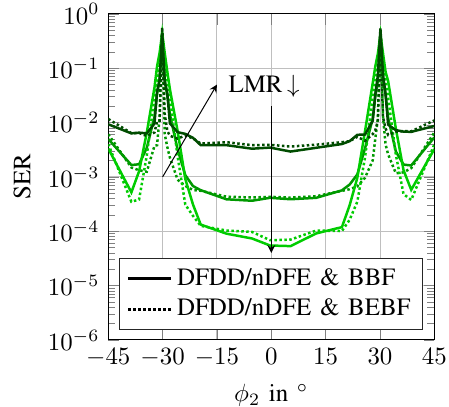
Figure 7. Symbol error rate vs. angle φ 2 of user 2 at different LMR considering the full-array architecture: LMR = 0dB ( ), LMR = 10dB ( ), LMR = 20dB (